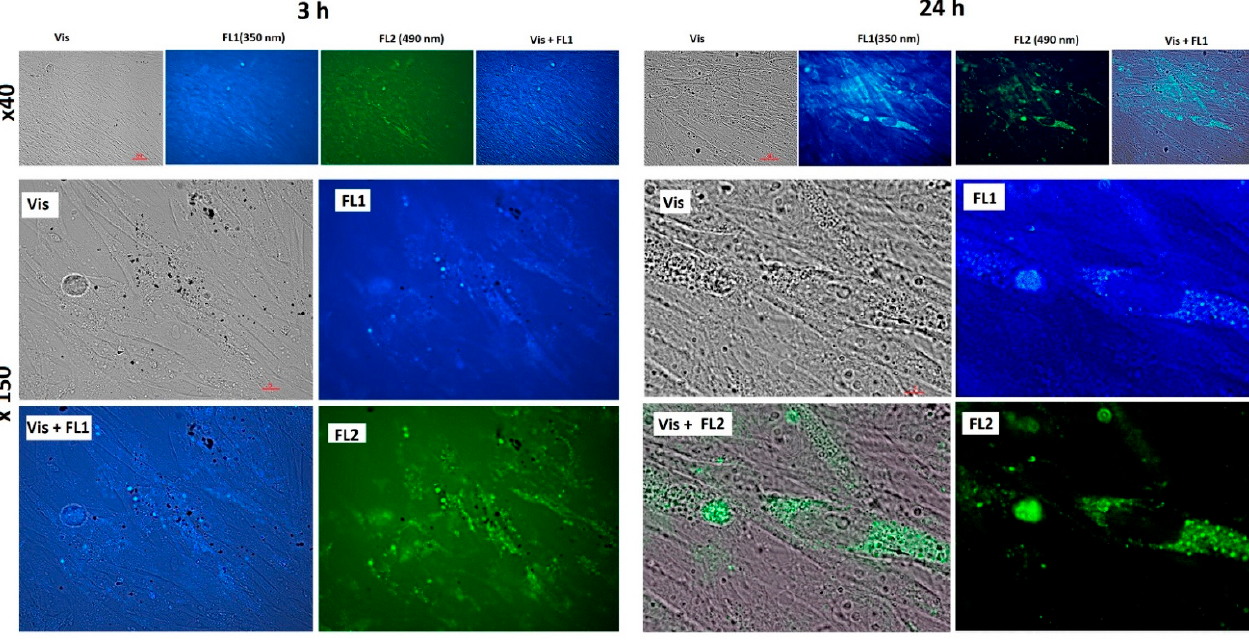
Figure 6. Fluorescence of Gd@C 82 (concentration 1.5 µM) in the cells after 3 and 24 h of incubation: Vis—transmitted light, fluorescence was registered with a 450–525 nm filter, excitation wavelength 350 nm (FL1) and 490 (FL2); magnification is shown at the left. Scale is marked with red bars.